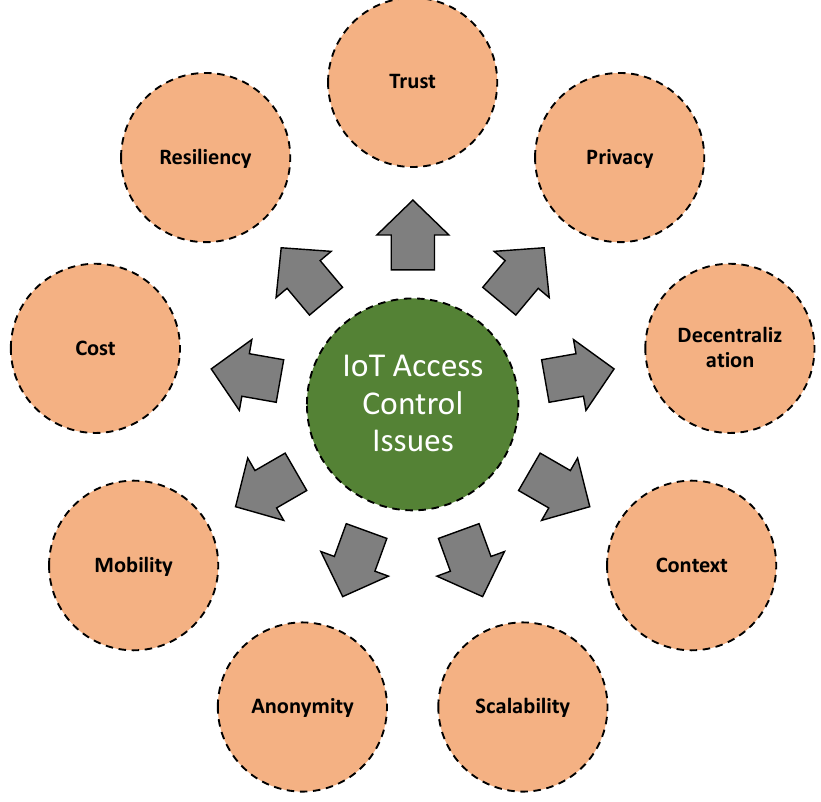
Figure 8. A list of significant issues associated with IoT access